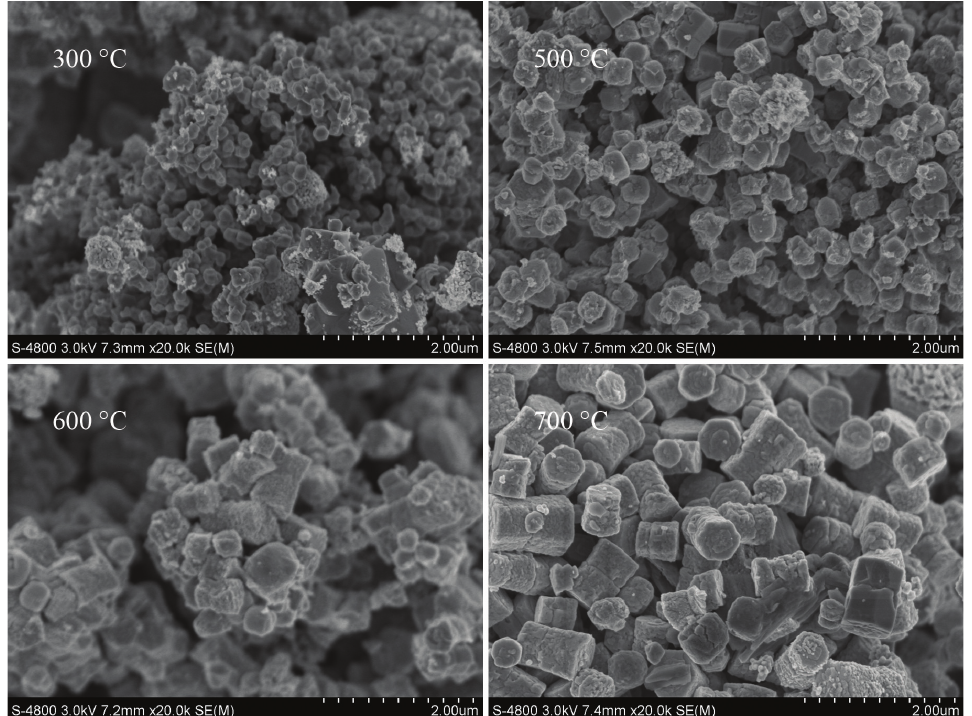
Figure 5. SEM images of 7 at% Sn-doped ZnO annealed at different